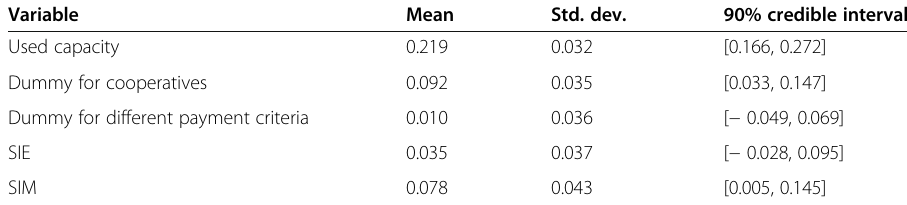
Table 5 Marginal effects of the variables in Z on TE Variable Mean Std.